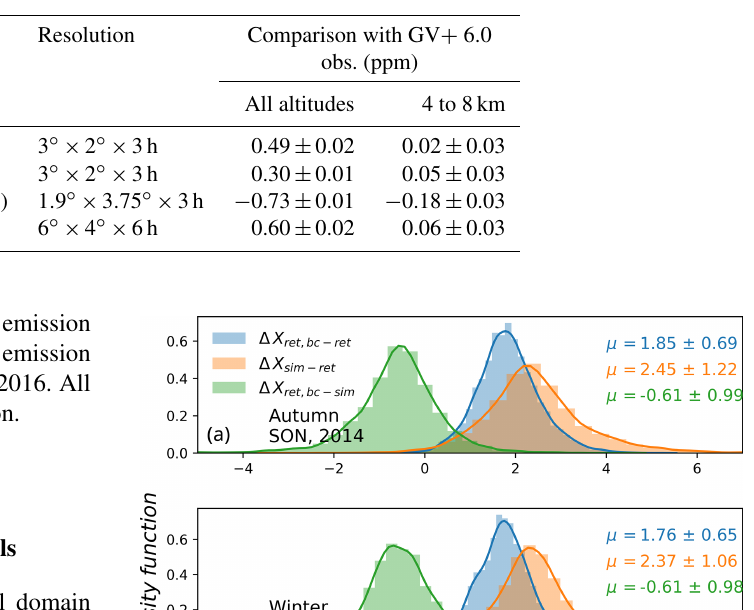
Table 1. Global CO 2 4D mole fraction fields used in this study. Comparisons with the Global Monitoring Laboratory (GML)’s GlobalView Plus version 6.0 data product are also presented. These comparisons are provided for all assimilable observations and all assimilable obser- vations between 4 and 8km. For more information on the models, see the text.